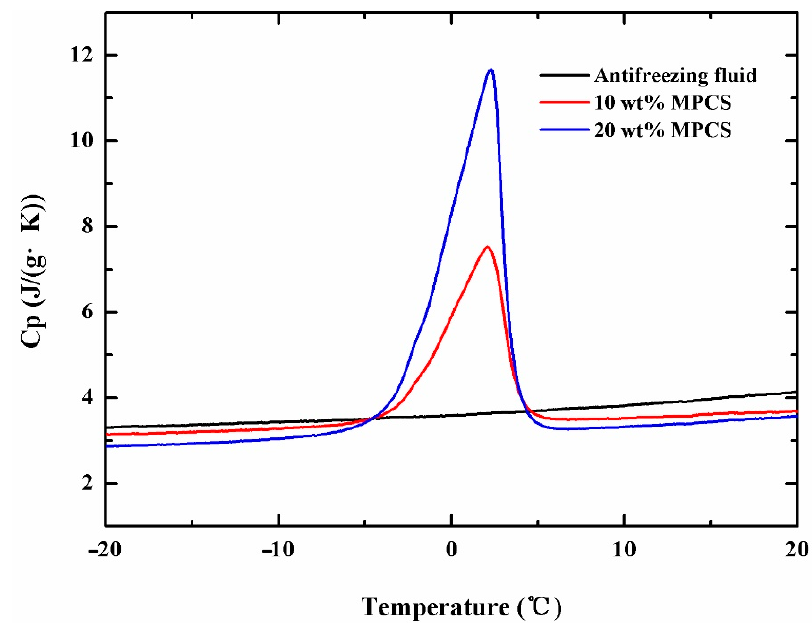
Figure 7. The specific heat capacity with different latex concentration.